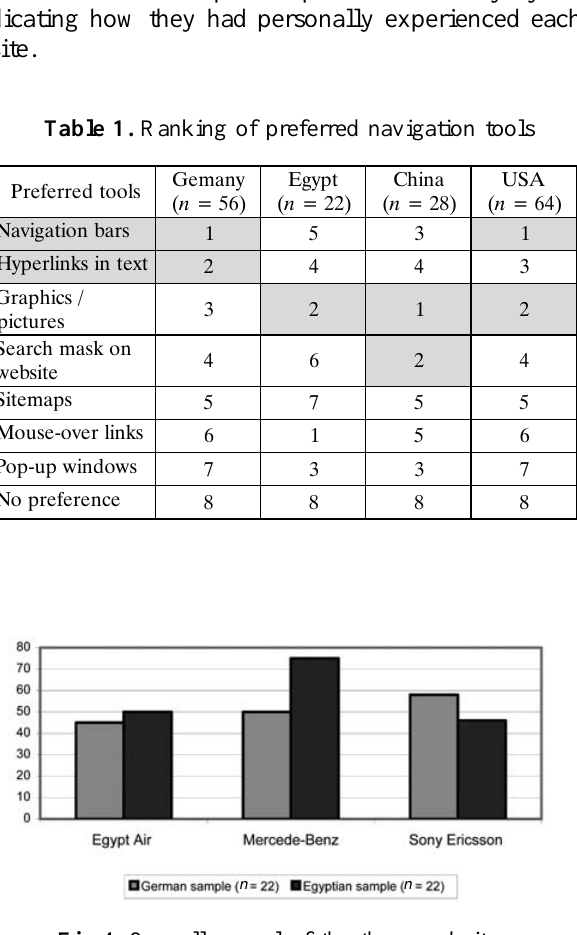
Fig 4. Overall appeal of the three